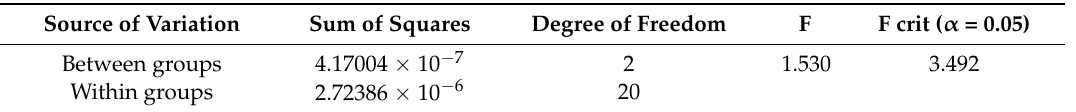
Table 4. Results of the one-way ANOVA for statistically significant differences in the soils, vine branches, and wine data reported in Table 3.